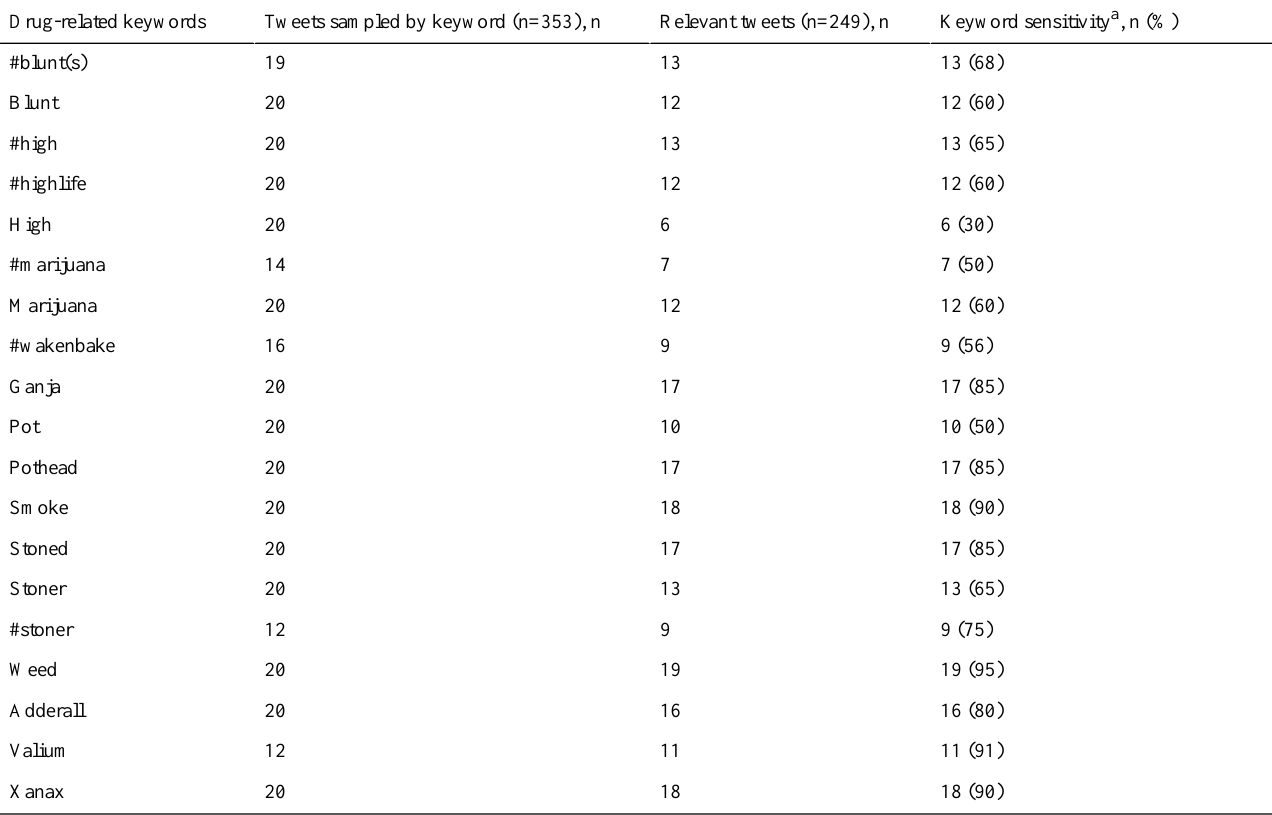
Table 1. Drug-related keywords, number of tweets sampled by keywords, relevant tweets, and keyword